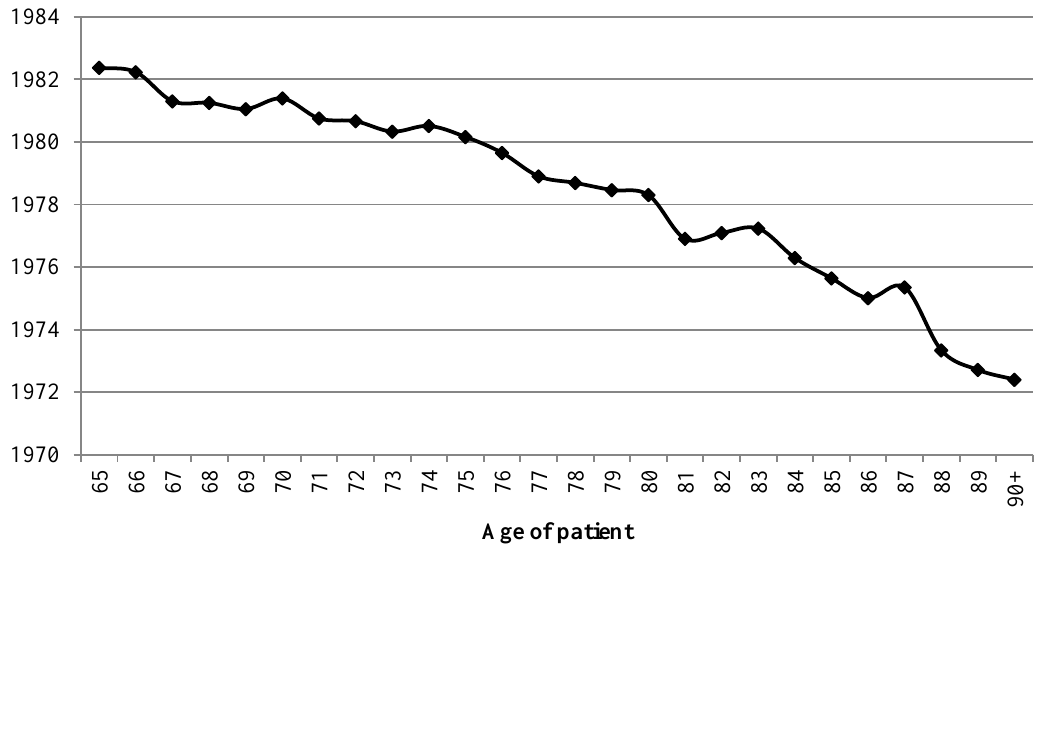
Figure 4: Relationship between age of patient and cardiovascular drug